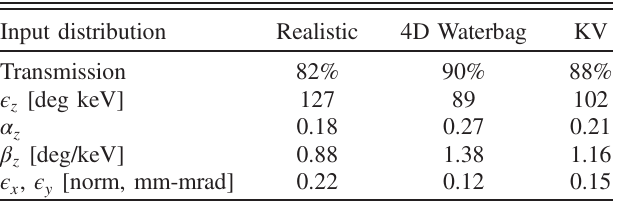
TABLE II. rms parameters of the bunch at the RFQ output, based on PARMTEQ simulation for different input distributions. Transmission calculated for 50 mA input current. Longitudinal emittances are 100%, unnorm.